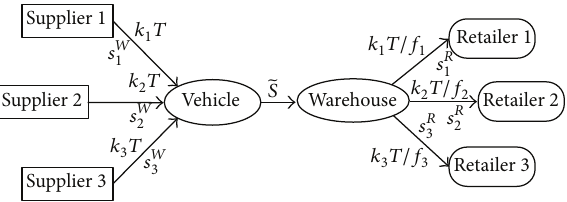
Figure 1: The JRD model (source: Cha et al.